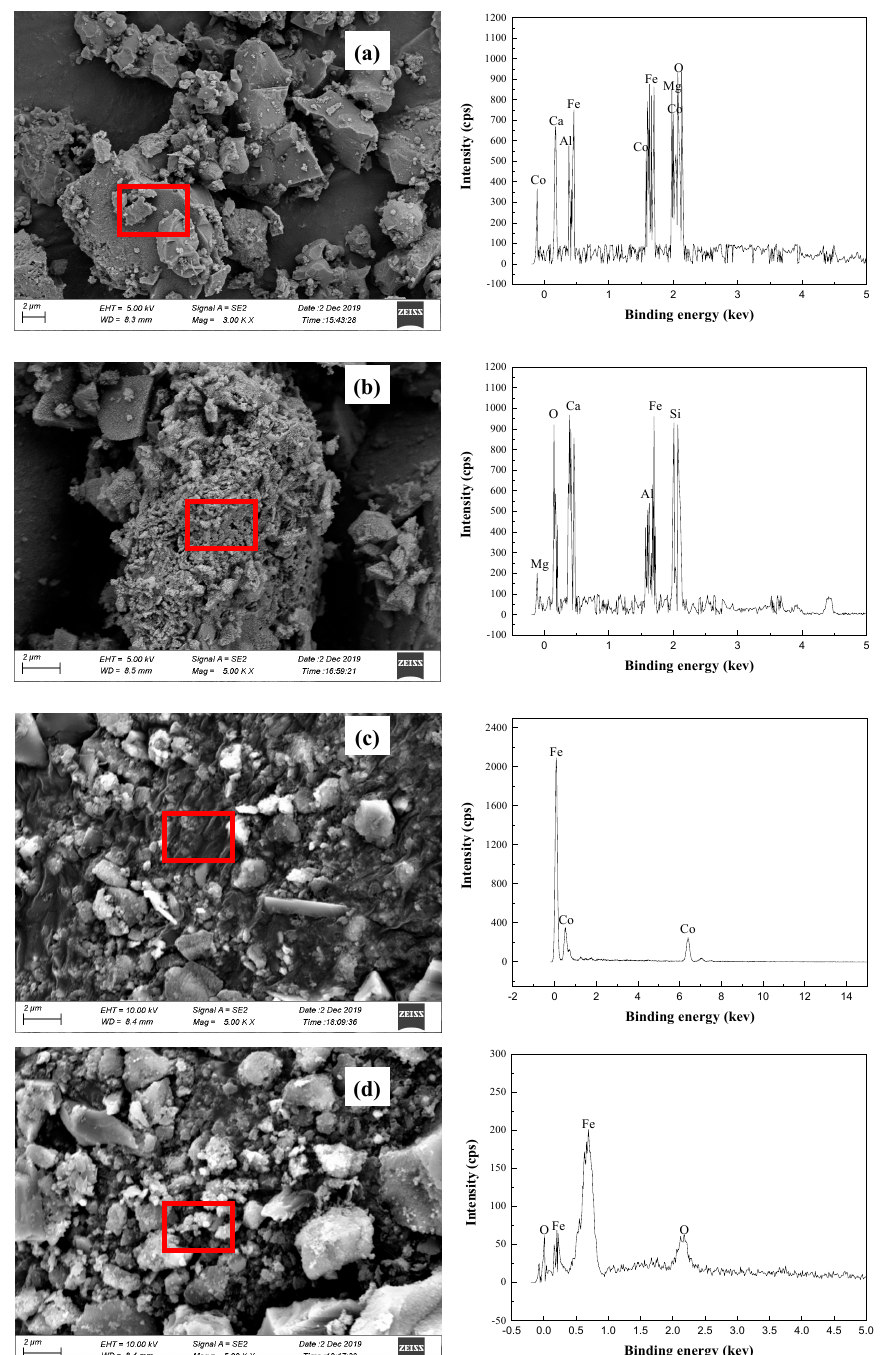
Figure 15. SEM and EDS images ( a —segregation roasting ores; b —tailings; c —cobalt concentrate; d —iron concentrate).